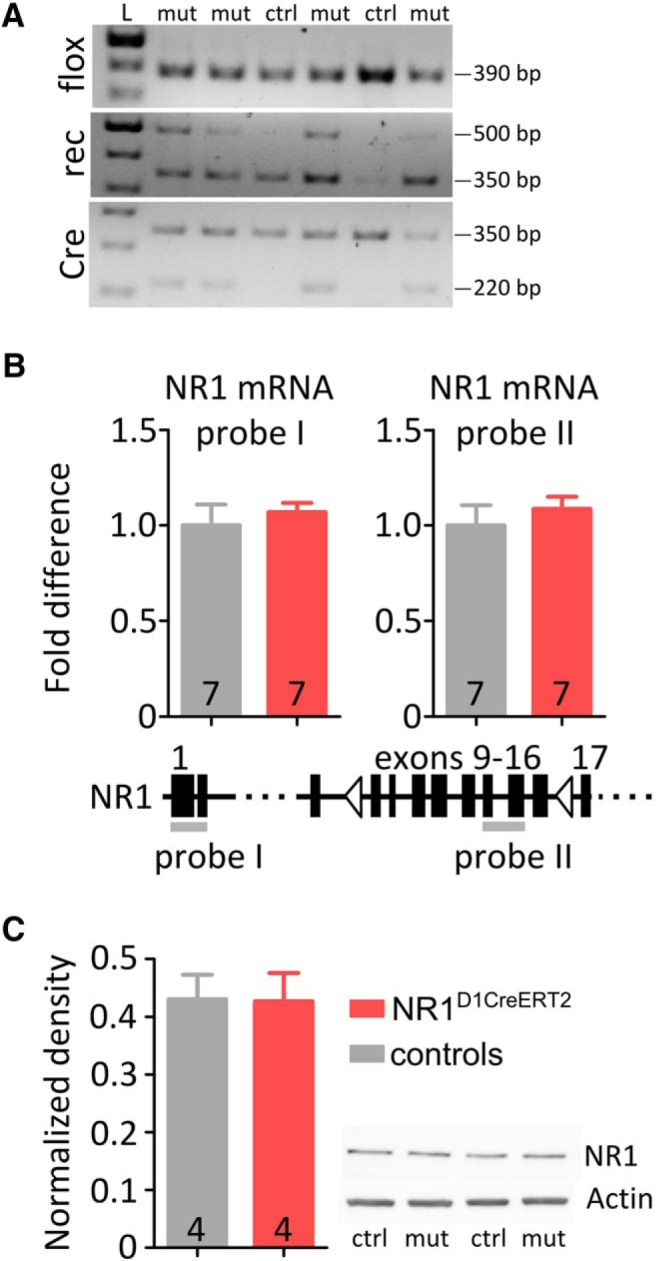
NR1 recombination and expression. A, PCR detection of the recombined NR1 allele in genomic DNA samples from the NAc and striatum of NR1D1CreERT2 mice and controls. The “flox” panel shows the presence of a single 390 bp band, confirming the flox/flox genotype. In the “rec” panel, the presence of a ∼500 bp band confirms recombination between the loxP sites, whereas the 350 bp band is an internal positive control. In the “Cre” panel, the 220 bp band confirms the presence of the D1CreERT2, and the 350 bp band is a positive control. B, Abundance of NR1 mRNA, as assayed by qPCR. The bar graphs show the relative abundance measured using probes targeting a non-recombined gene fragment (probe I) and the potentially deleted fragment (probe II; see the diagram below the graphs). The numbering of exons is based on the gene sequence ENSMUSG00000026959 and on the transcript ENSMUST00000028335. C, NMDA receptor subunit protein abundance detected by Western blotting and normalized to actin. A representative result is shown on the right. Error bars show SEM values, sample sizes are indicated on the bar graphs. There were no significant differences between sample means (t-test).